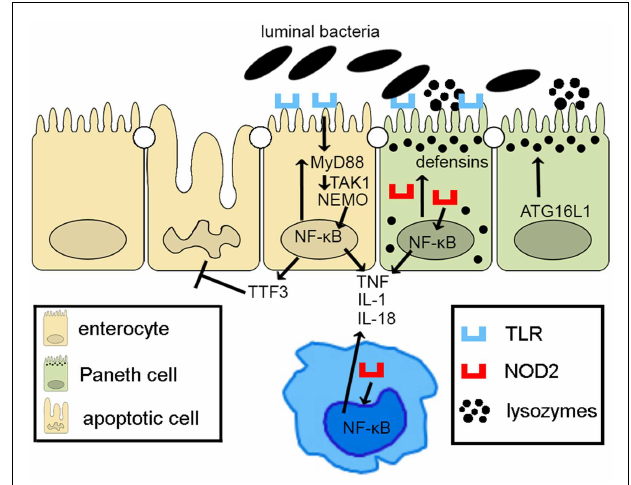
FIGURE 2 | Epithelial innate immune function is a key factor in maintaining gut homeostasis . IECs express PRRs, such asTLRs and NOD-like receptors, whose signaling activates NF- κ B, leading to reinforcement of the epithelial barrier through release of anti-microbial peptides (i.e., defensins) and paracellular secretion of proinflammatory cytokines (e.g.,TNF, IL-1, and IL-18) that enhance mucosal defense to bacterial penetration and the production of trophic factors, such as intestinalTFF3 that can block IEC apoptosis. Autophagy, perhaps due to ATG16L1, also contributes to the effectiveness of the epithelial barrier, controlling intracellular pathogens, and inducing lysozyme production. Breakdown of PRR/NF- κ B signaling pathways via critical components, including MyD88,TAK1, and NEMO, facilitates penetrance of luminal microorganisms, triggering an exaggerated adaptive immune response. Similarly, defects in autophagy lead to less effective bacterial clearance and production of proinflammatory molecules, such as adipokines and acute phase reactants from Paneth